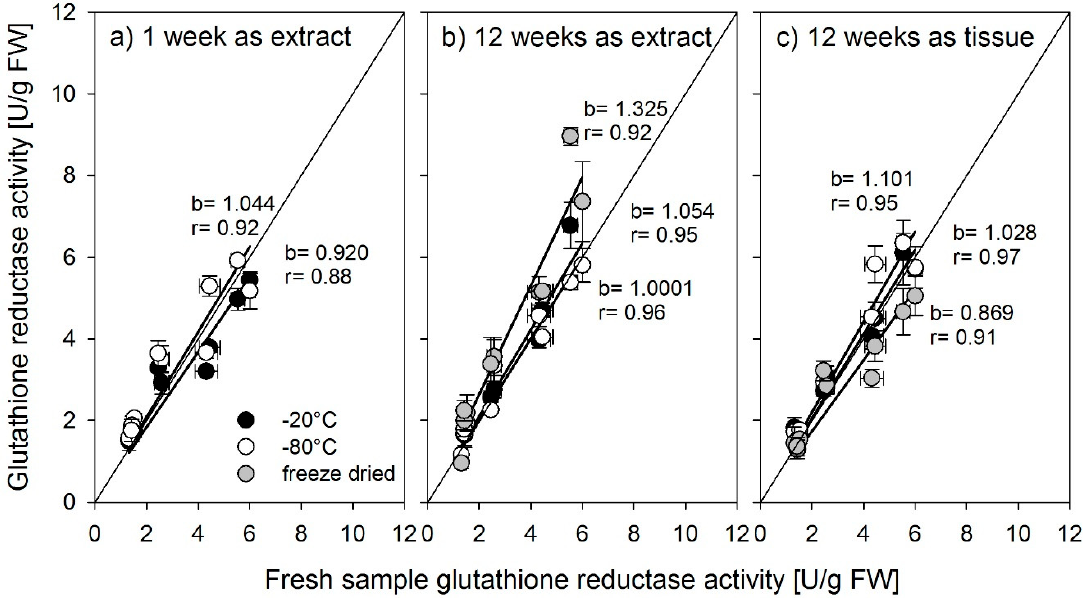
Figure 4. Glutathione reductase activity determined from fresh samples compared with activity determined after storage at − 20 °C, (black symbols), − 80 °C (open symbols), or freeze-dried extracts of tissue (gray symbols) for ( a ) 1-week storage time or ( b,c ) 12 weeks storage time. b = slope of the regression line, r = the correlation coefficient r 2 . Error bars = standard error of mean (n = 3). ◦ ◦ Storing extracts at − 20 C or − 80 C for one week did not a ff ect the activity of superoxide dismutase